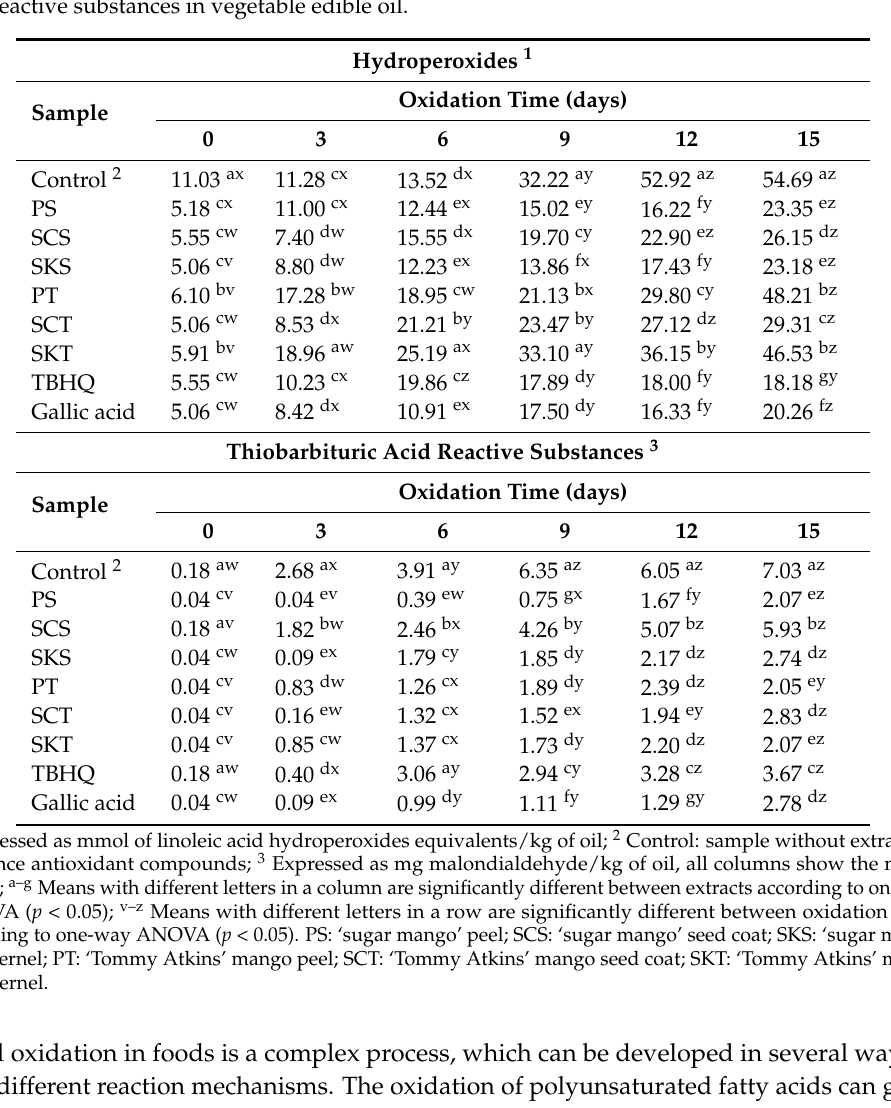
Table 2. Antioxidant effect of the extracts obtained from agroindustrial mango waste, tert- butylhydroquinone (TBHQ), and gallic acid on the formation of hydroperoxides and thiobarbituric acid reactive substances in vegetable edible